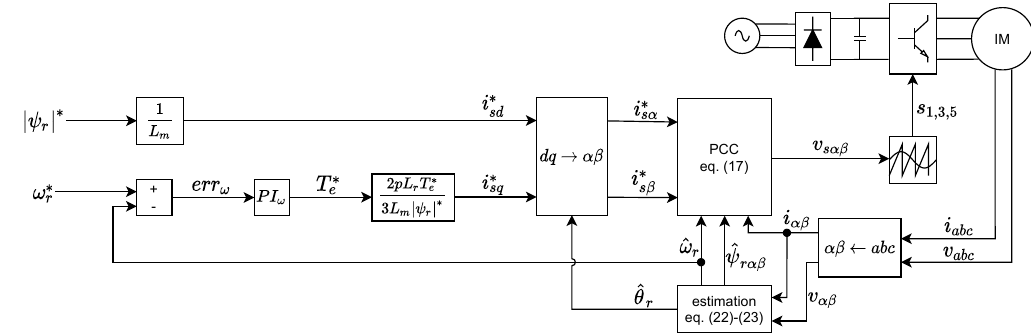
Figure 1. Block diagram of the control method.